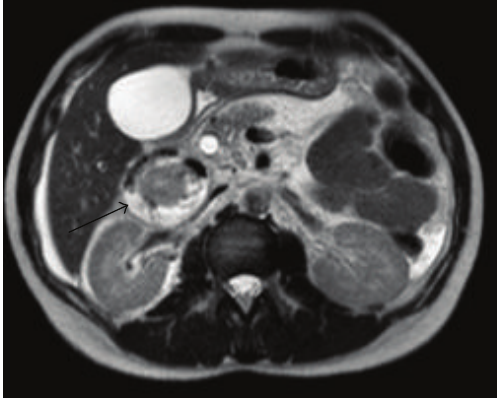
Figure 2: MRCP slice showing an air-fluid filled cyst (arrowed) posterior to the head of the pancreas.